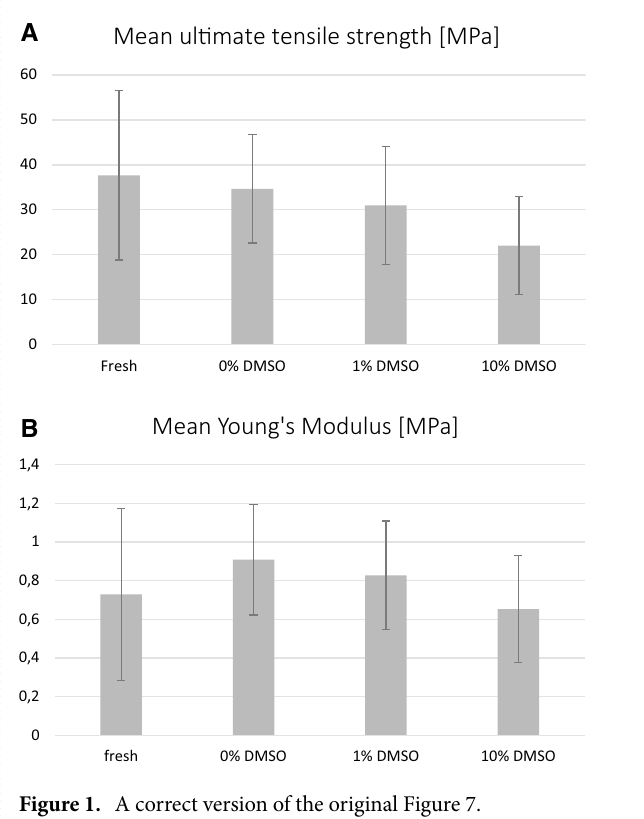
Figure 1. A correct version of the original Figure